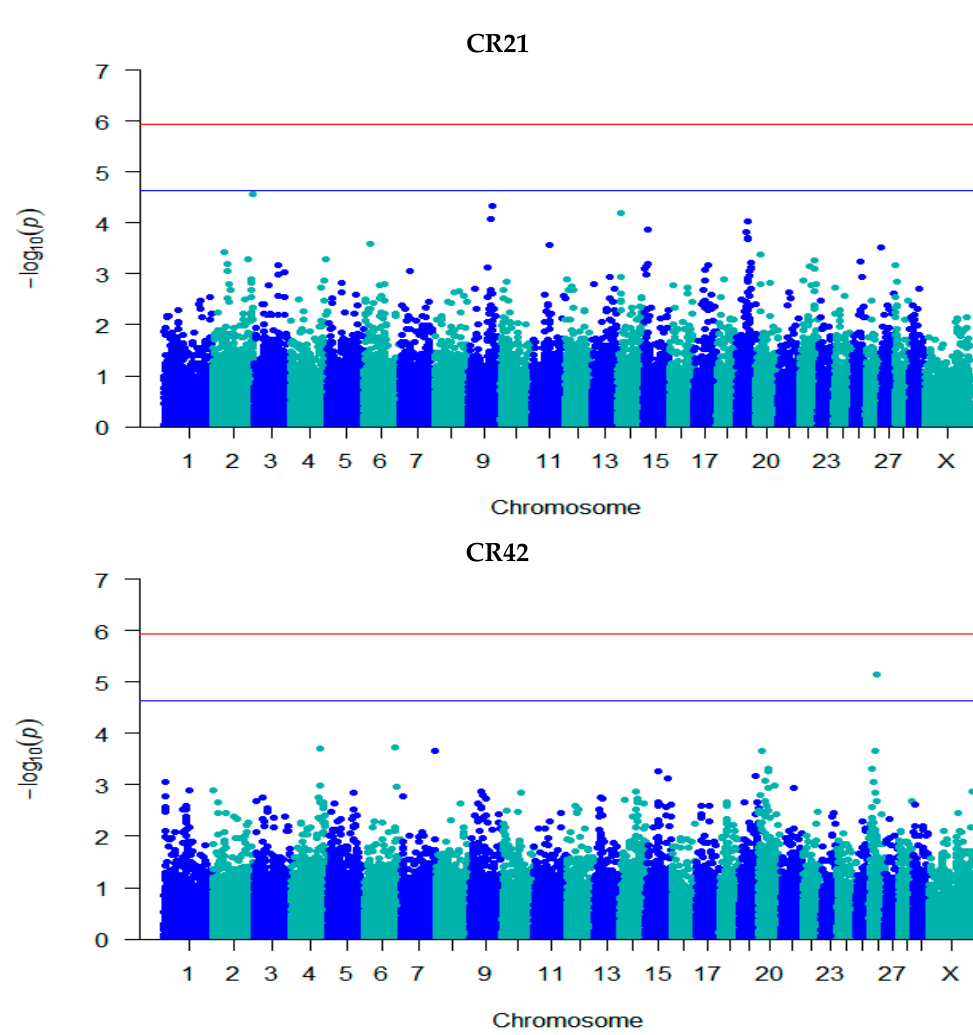
Figure 2. Manhattan plots for − log 10 p -values of marker effects for the interval from the start of mating to first service (SMFS), the interval from the start of mating to conception (SMCO), the interval from first service to conception (FSCO), the interval from calving to first service (CFS), consecutive calving intervals (CI), 3 weeks submission (SR21), 6 weeks submission (SR42), 3 weeks in-calf (PR21), 6 weeks in-calf (PR42), pregnant to first service in the first 3 weeks of the breeding season (PRFS), not in calf at end of the breeding season (NIC), 3 weeks calving (CR21), and 6 weeks calving rate (CR42). The genome-wide significance threshold of Bonferroni correction is represented by the red line at − log 10 p -value = 5.93, and the suggestive significance threshold is represented by the blue line at − log 10 p -value = 4.63. Table 4. The single nucleotide polymorphisms (SNPs) that w ere identified as significant at ge- nome-wide and suggestive significance thresholds for the fertility traits.